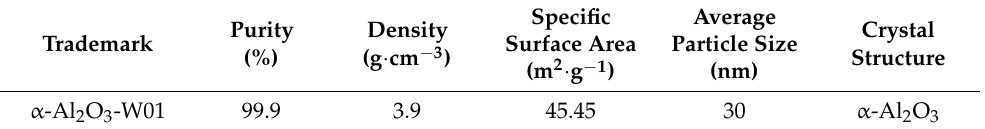
Table 2. Properties of α -Al 2 O 3